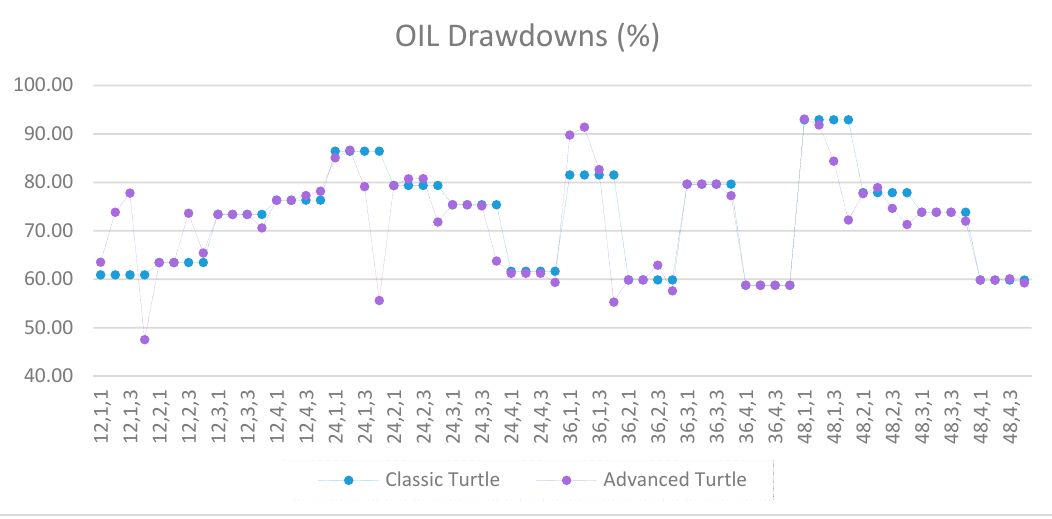
Figure A46. Drawdowns of OIL as percentage of equity between the classic and the advanced Turtle systems for every combination of N, X, Y for the slow parameters (80, 160).